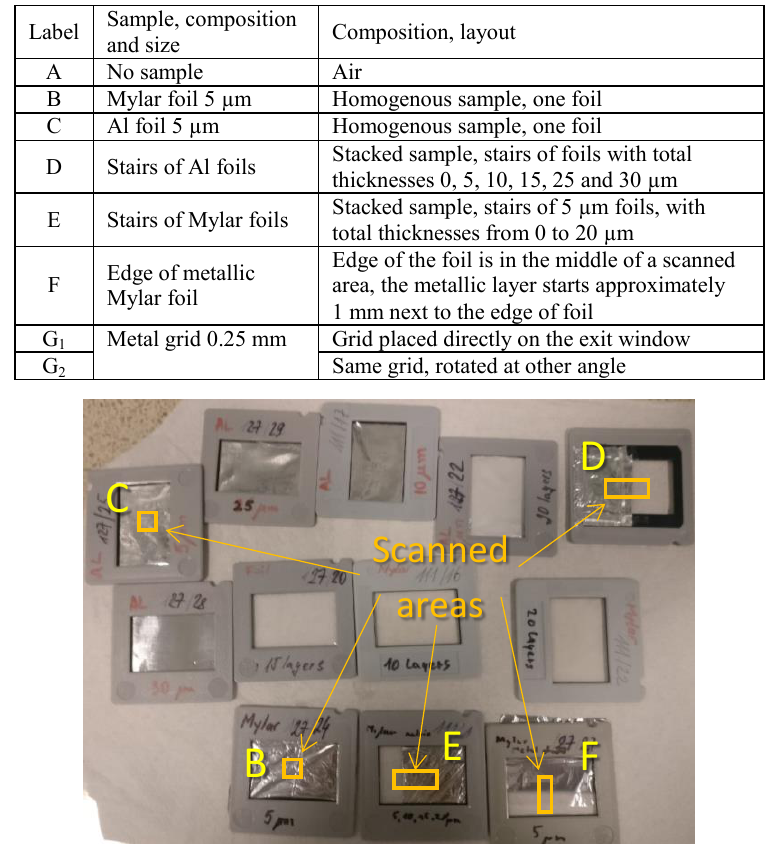
Table 1. Imaging samples used. Composition, labels, foil thickness are given.